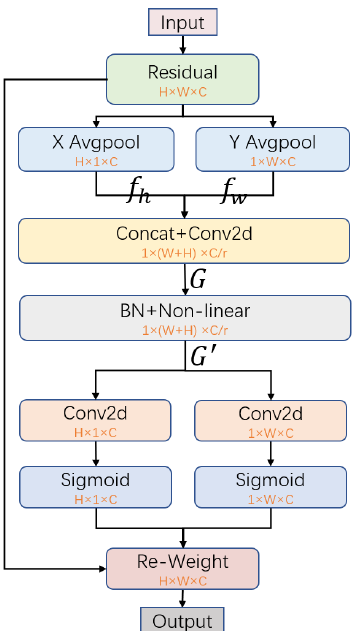
Figure 5. Network structure of coordinate attention